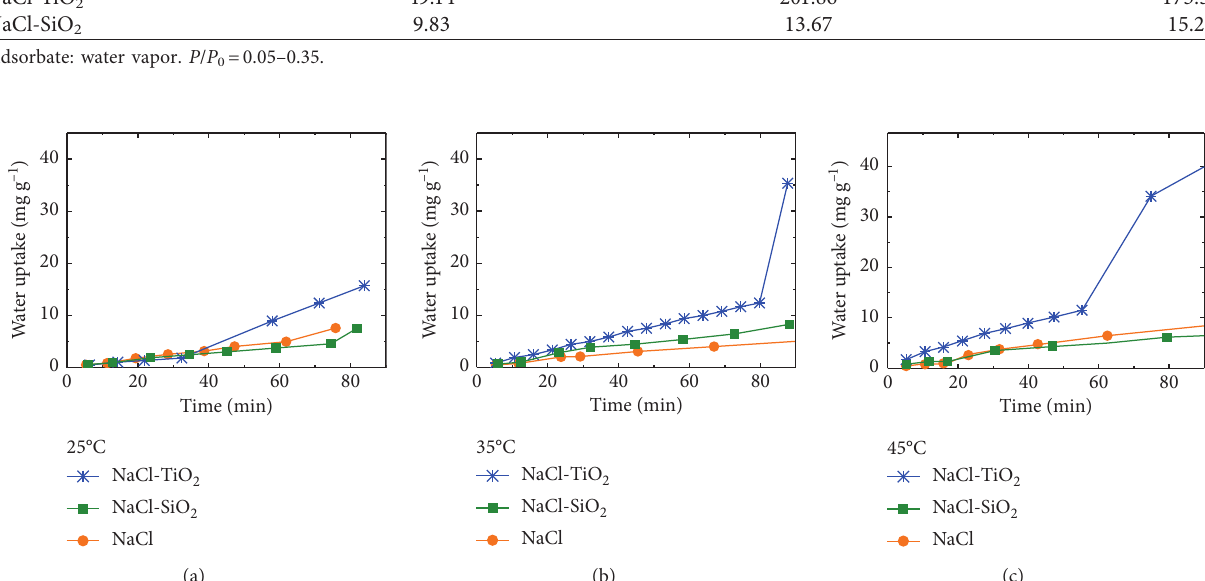
° C, (b) 35 ° C, and (c) 45 ° 2 , and NaCl-SiO 2 at (a) 25